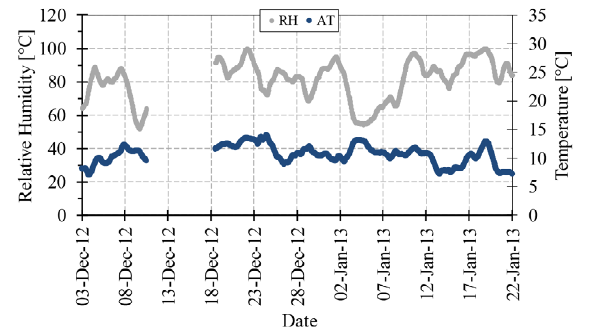
Figure 8. Temporal variation of air temperature and relative hu- midity over the monitoring period (data are measured through a combined temperature/humidity sensor installed in a nearby